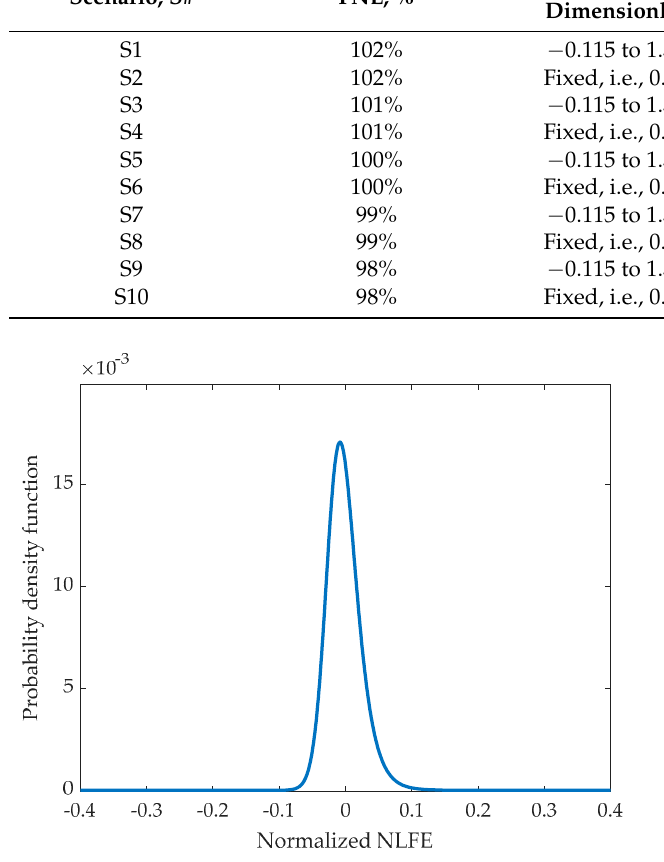
Figure 7. Probability density function of normalized NLFE.